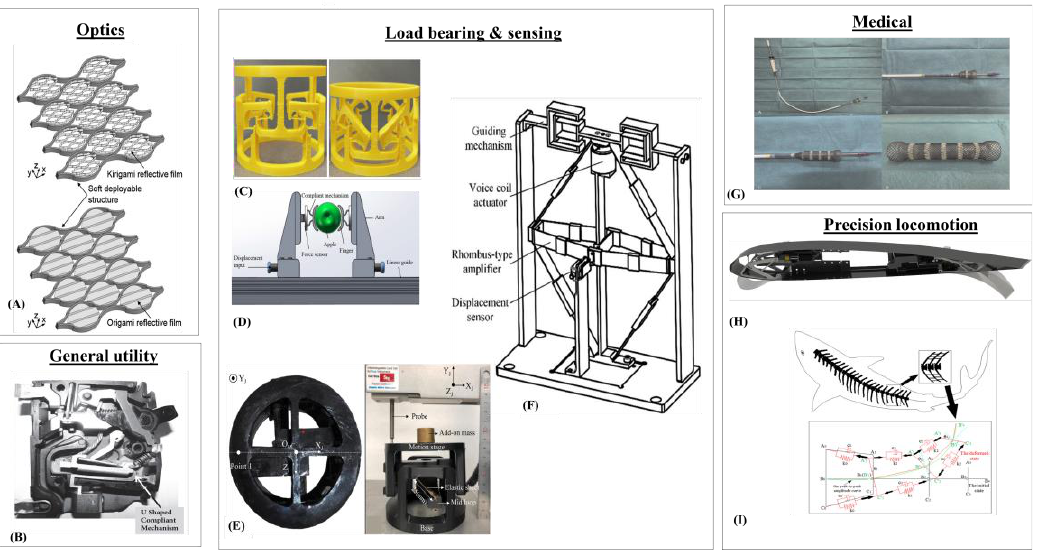
Figure 1. Examples of CMs in the clockwise direction. ( A )Optical beam reflecting [11]; ( B ) Miniature circuit breakers [9]; ( C ) Load bearing deployable structure [13]; ( D ) Constant-force fruit picker [7]; ( E ) Anti-buckling universal joint [14]; ( F ) Electromagnetic force balance sensor [15]; ( G) A self-expanding stent[16]; ( H ) Morphing flight wing [8]; ( I ) Robotic fish [12].